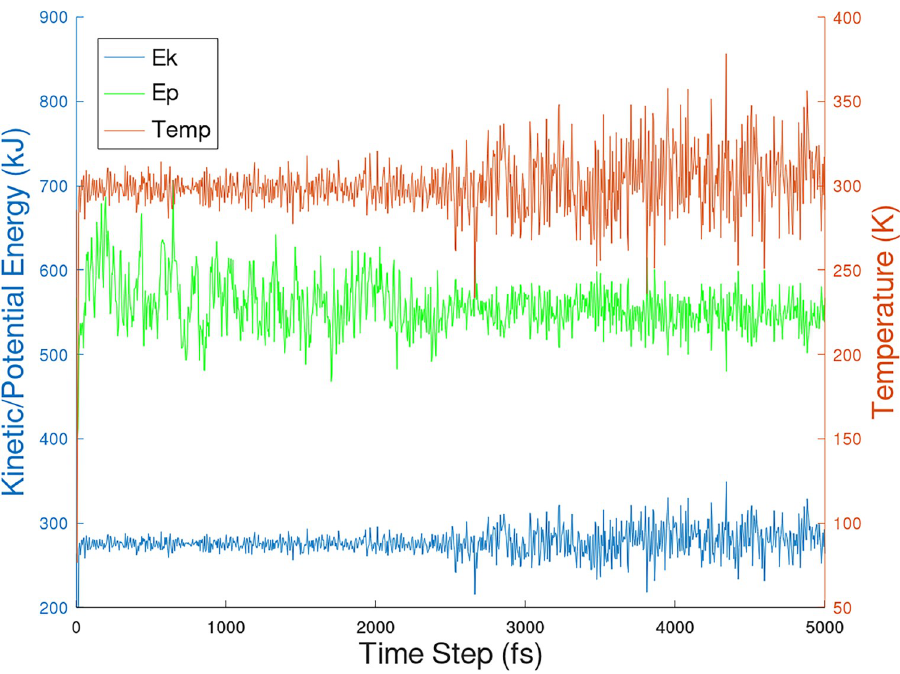
Fig 9. Kinetic, potential and temperature variations in molecular dynamics simulations of of 3-alpha-cholesterol docked structure with RMSD = 0.